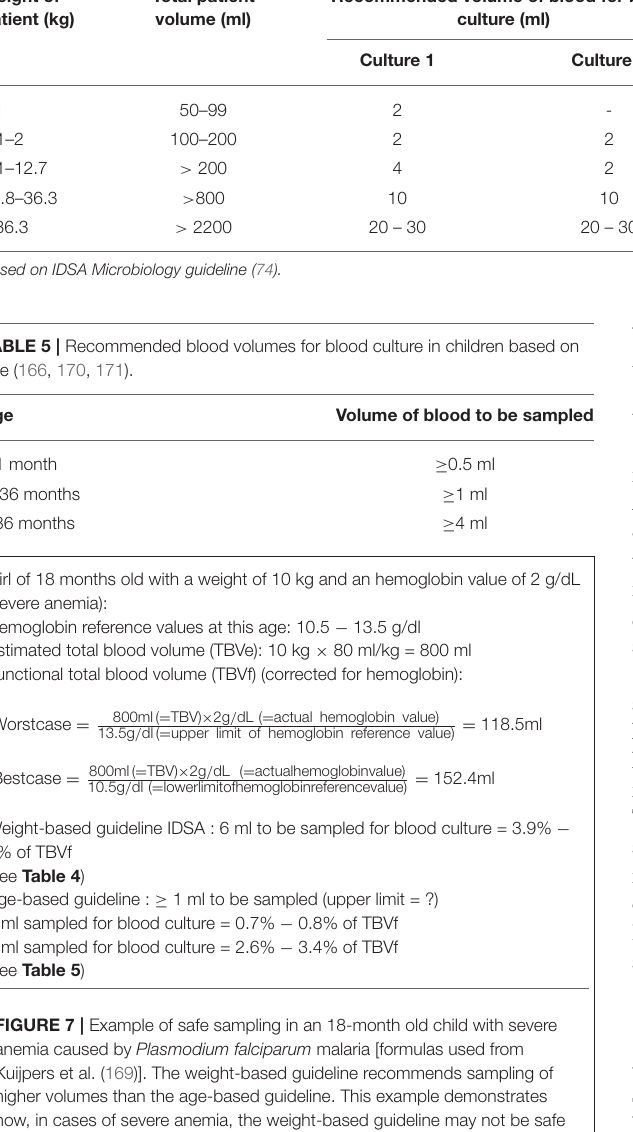
TABLE 4 | Recommended volumes of blood for culture in children. Weight of patient (kg)